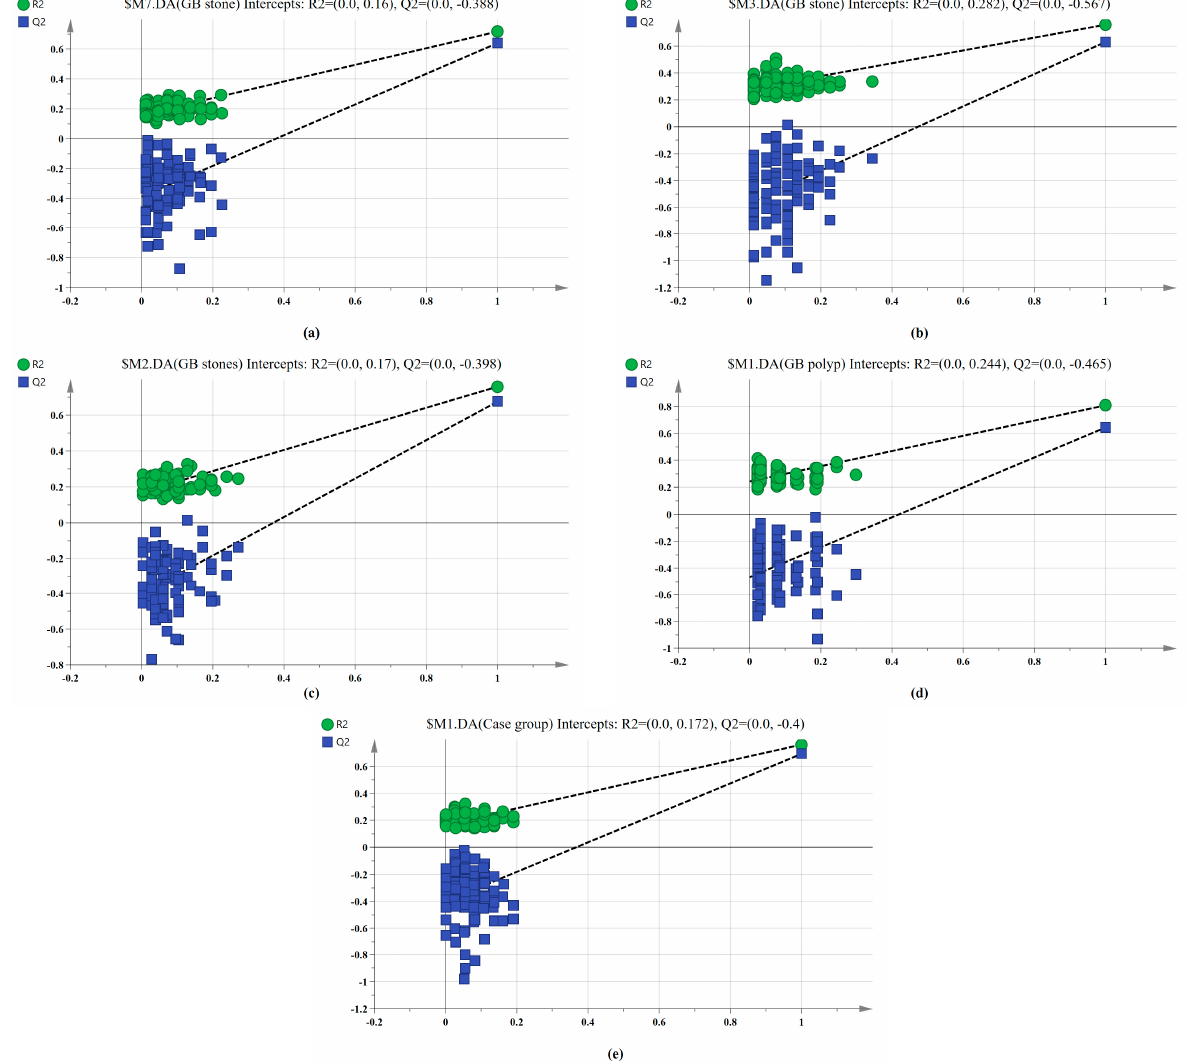
Figure 4. 100-permutation test of the SERS data for three types of serum based on OPLS-DA. ( a ) Healthy, GB stone, and GB polyp classification models. ( b ) GB stone vs. GB polyp classification models. ( c ) Healthy vs. GB stone classification models. ( d ) Healthy vs. GB polyp classification models. ( e ) Healthy vs. Case group classification models.